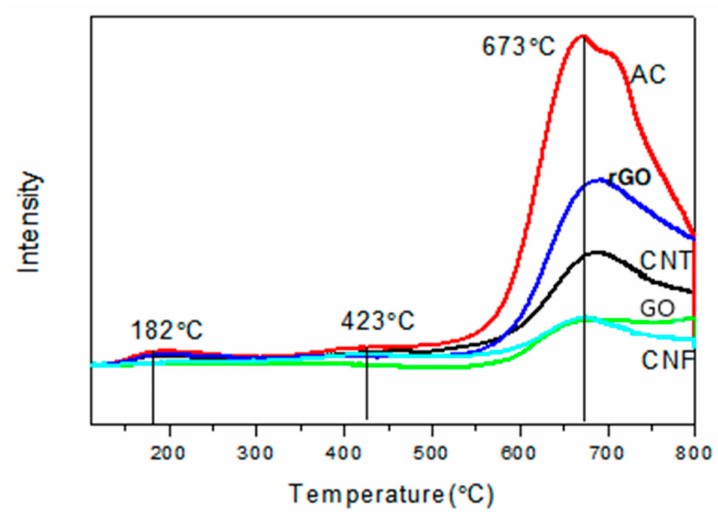
Figure 9. NH 3 -TPD profiles of different carbon-supported cobalt catalysts.